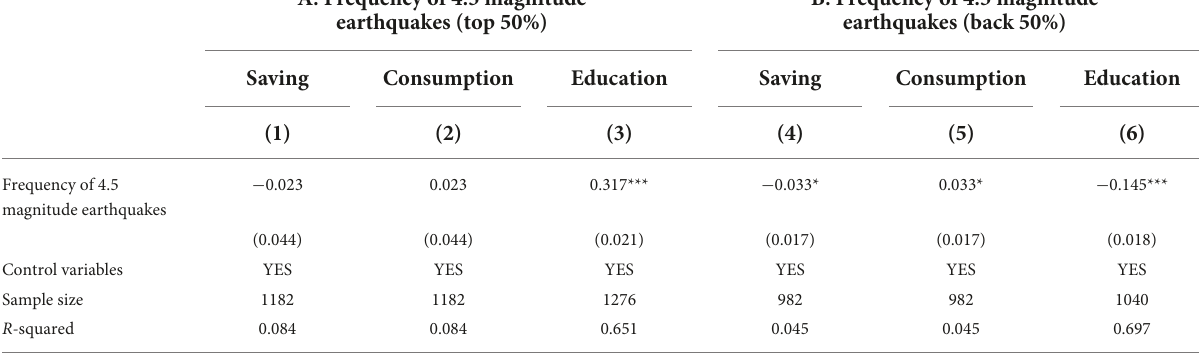
TABLE 9 Heterogeneity test: mean